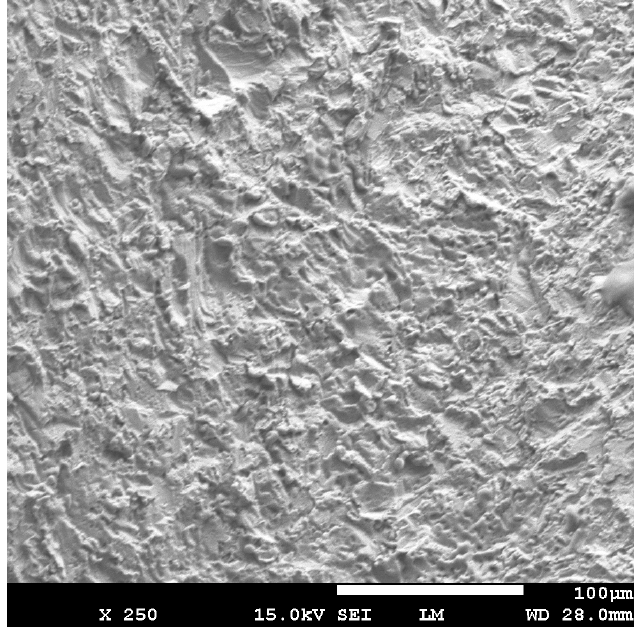
Figure 4. Scanning Electron Microscope (SEM) view of the lased area of contaminated implant (group C + L). The surface showed a clean aspect without alteration, melting areas or cracks.